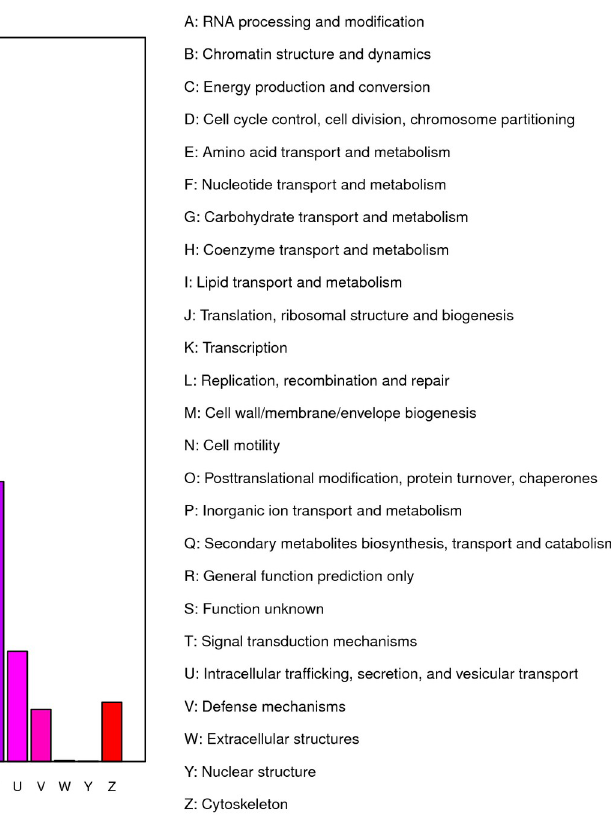
PLOS ONE | https://doi.org/10.1371/journal.pone.0278551 December6,